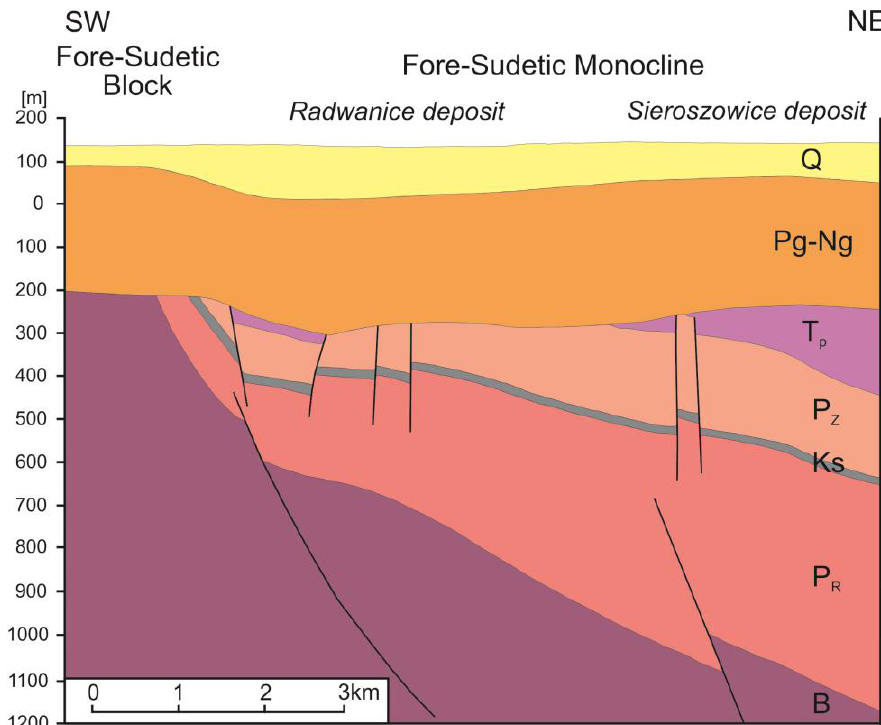
Figure 6. Schematic cross-section across the contact zone between the Fore-Sudetic Block and the Fore-Sudetic Monocline through the Radwanice deposit and SW part of the Sieroszowice deposit. Q, Quaternary; Pg-Ng, Paleogene-Neogene; Tp, Buntsandstein; Pz, Zechstein; Ks, Kupferschiefer series; P R , Rotliegend; and B, pre-Permian basement.